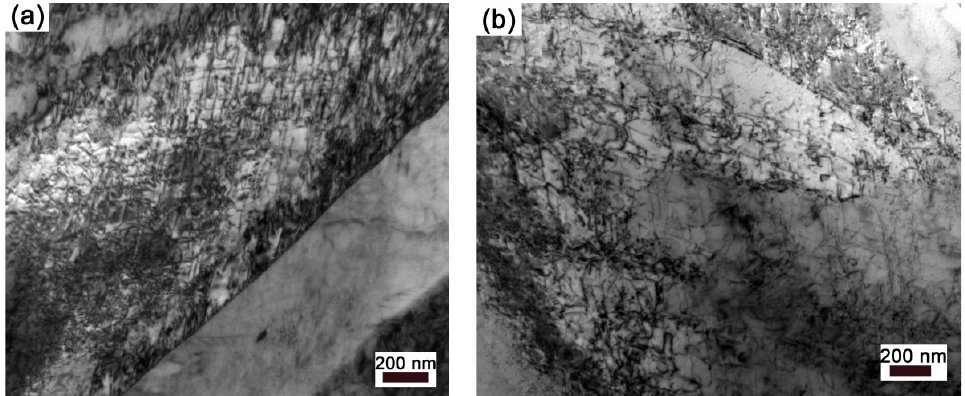
Figure 6. TEM images of samples deformed in air ( a ) and in H 2 SO 4 solution ( b